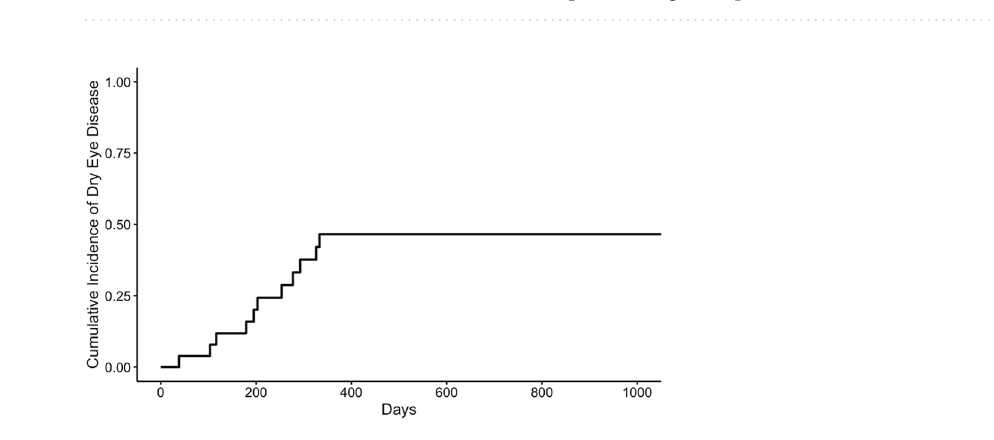
Table 1. Characteristics of patients with DED and patients without DED. DED dry eye disease; GVHD graft- versus-host-disease; SD standard deviation; IQR interquartile range; ( +) positive.